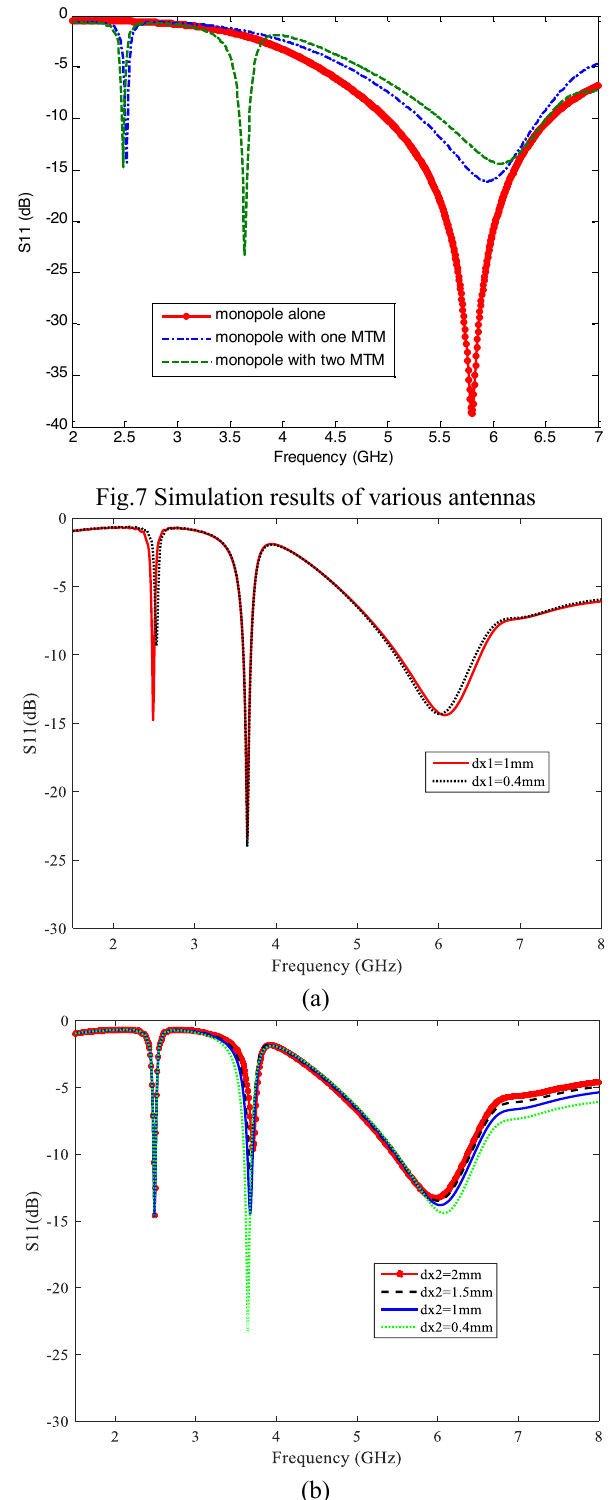
Fig.6 and table 1, the proposed antenna gets three distinct bands centered at about 2.5, 3.62 and 5.83 GHz as shown in Fig.7. The resonance around 2.5 is produced by the right unit cell and the resonance at 3.62 GHz from the left unit cell.